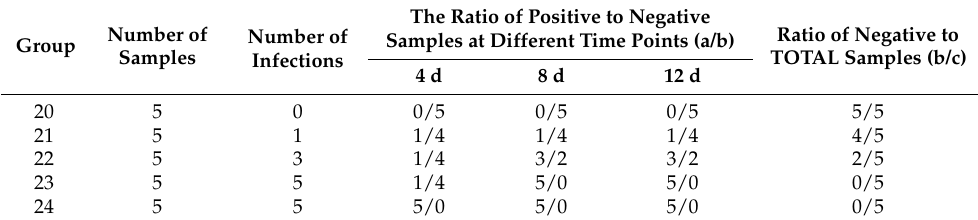
TOTAL Samples (b/c)